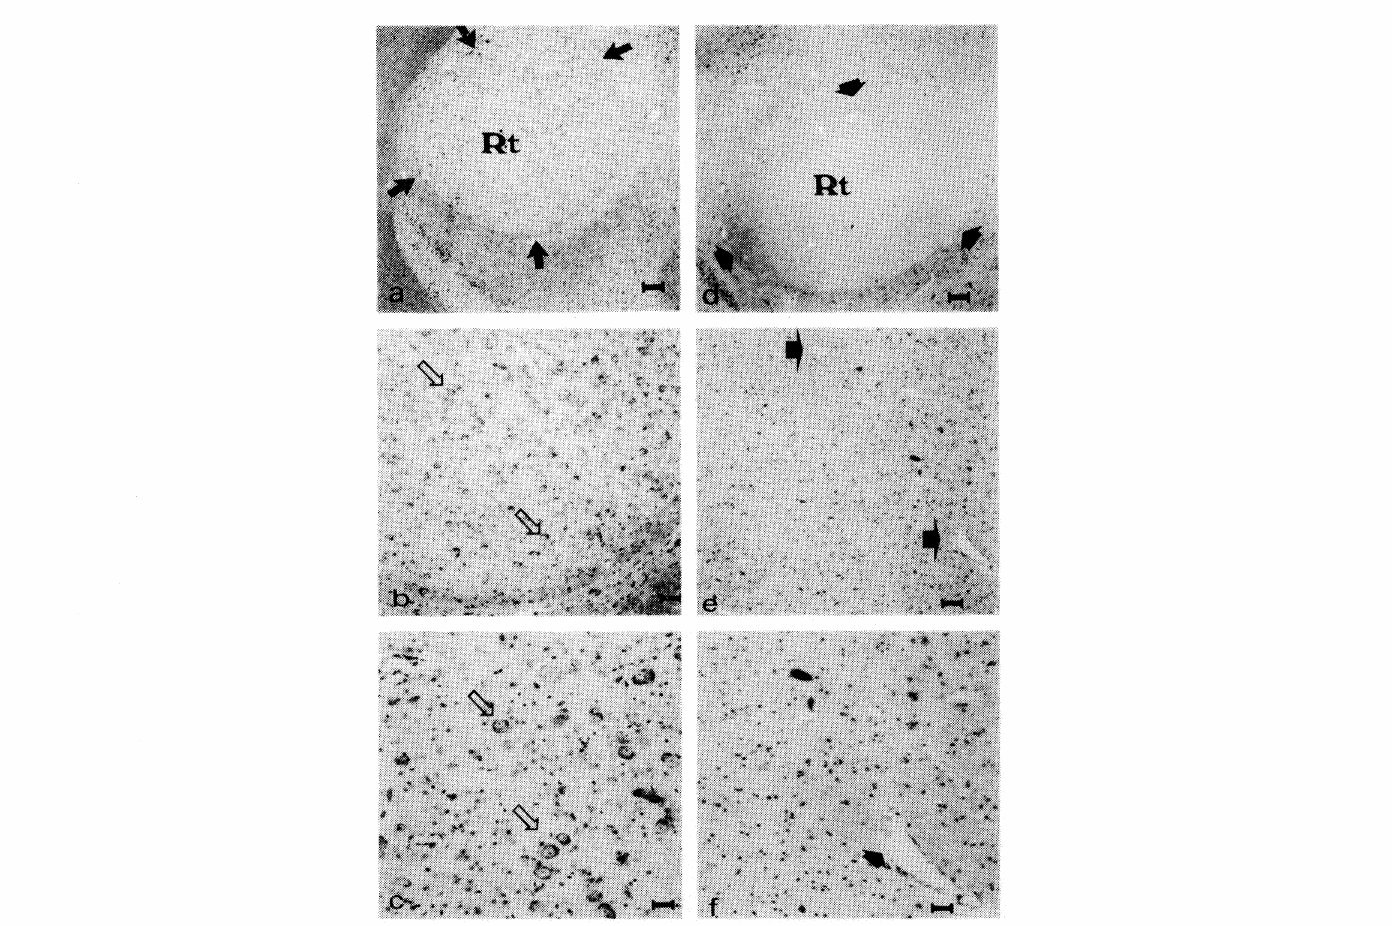
Microphotographs with frontal sections (101am) of a control (A-C) and of a telencephalon lesioned brain (D-F). The sections were stained with KI0ver-Barrera technique for visualization of myelinated axons. The black arrows indicate the perimeter of nRt (a and d) or neuronal bodies (c); white arrows indicate vessels (e and f). The lesioned pigeon was sacrificed 120 days after